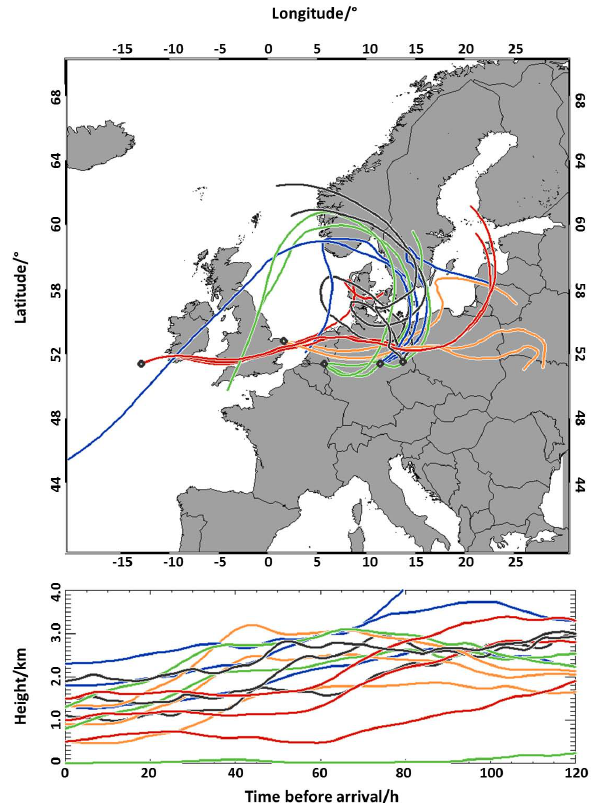
Fig. 2. 5-day backward trajectories for the locations of flight mis- sions during the first half of the EUCAARI-LONGREX field cam- paign. The trajectories start in height levels identified by the lidar measurements and considered as pollution aerosols (also see Ta- ble